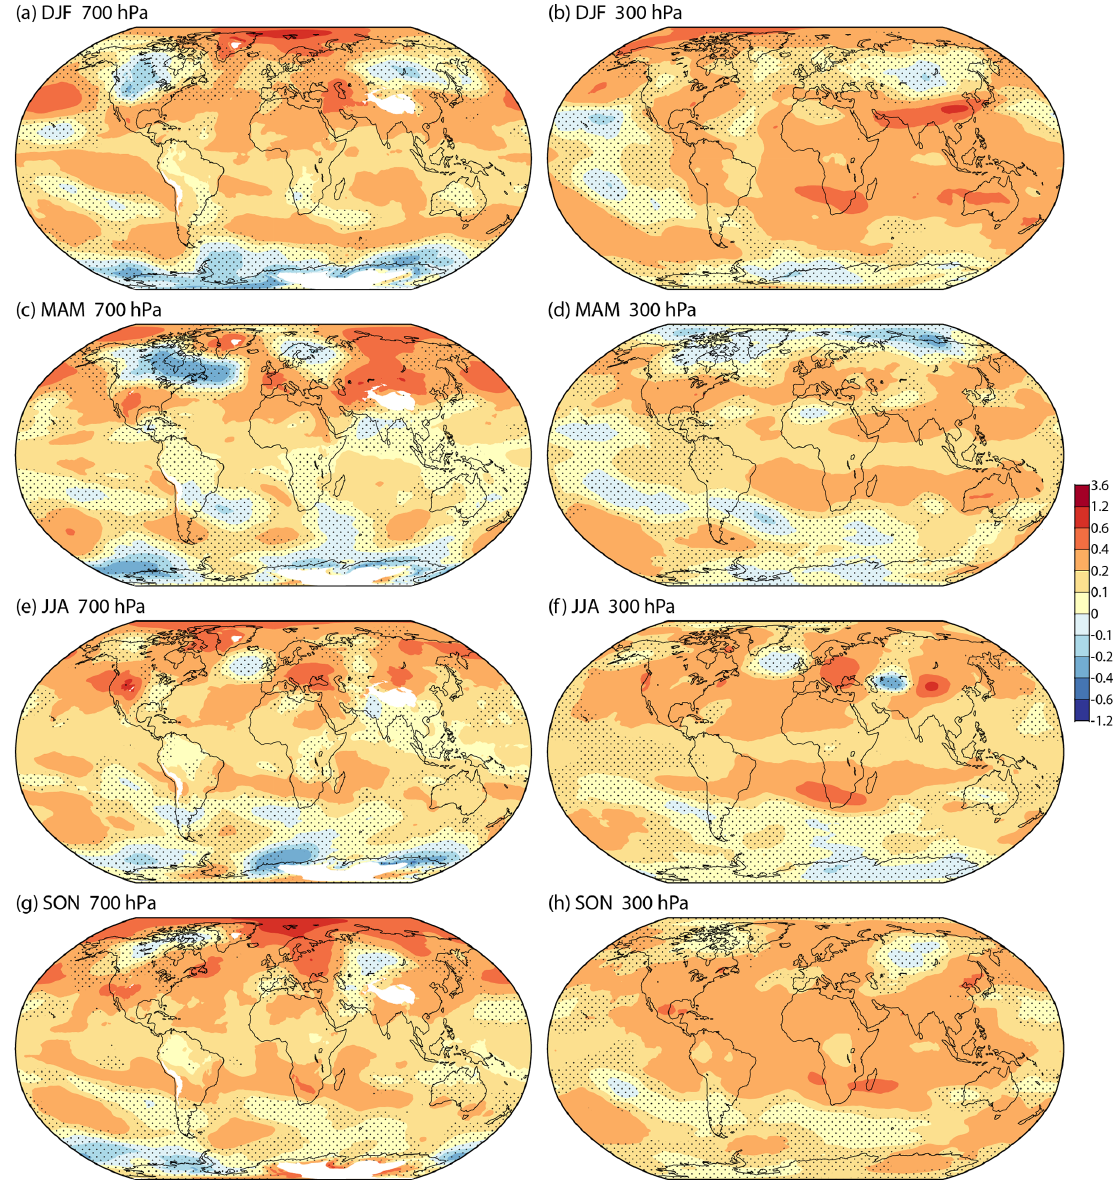
Figure 5. The least squares linear trend (K per decade) in 700hPa (left) and 300hPa (right) temperature based on seasonal-average ERA5 data from March 1979 to February 2022 for (a, b) DJF, (c, d) MAM, (e, f) JJA and (g, h) SON. Dots show where the 95% confidence interval is two-signed. 700hPa regions where the ERA5 model orography exceeds 3000m are masked in